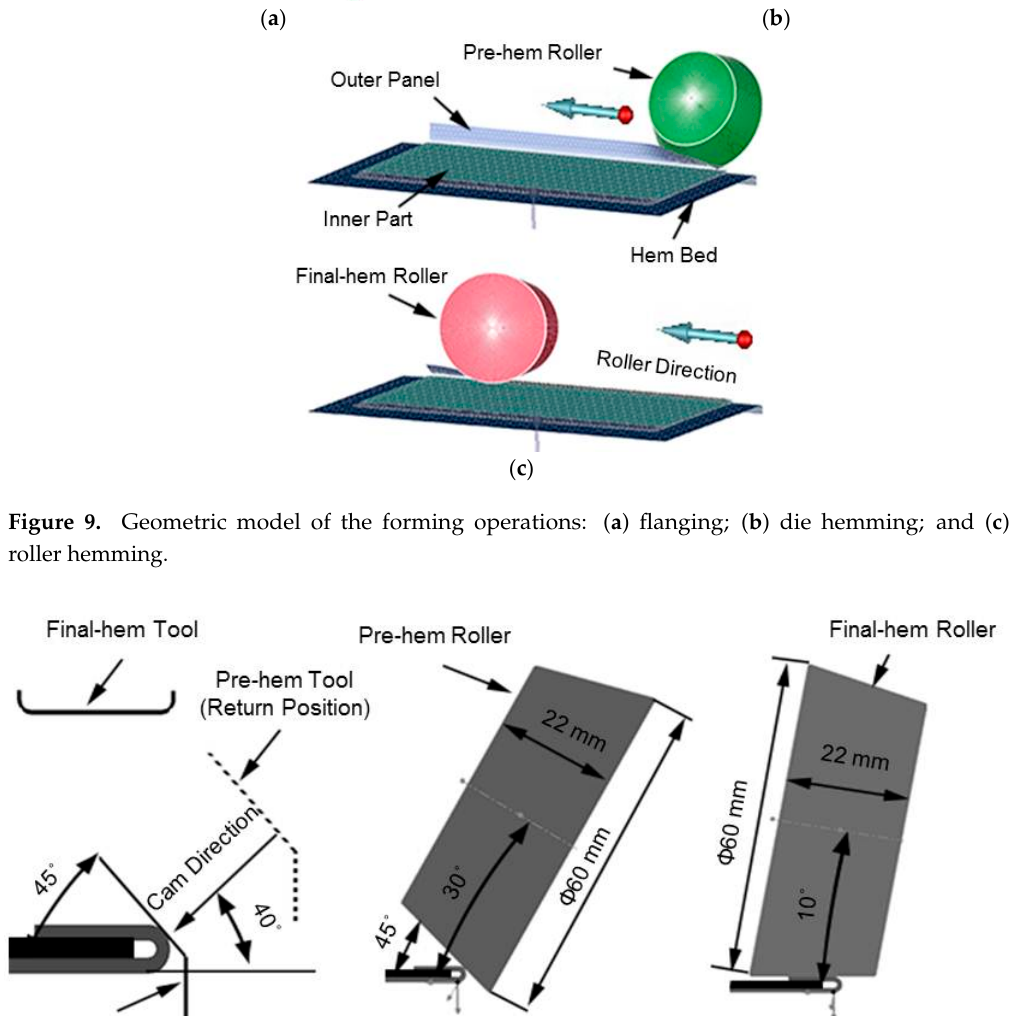
Figure 10. Trajectory parameters of the hemming tools.